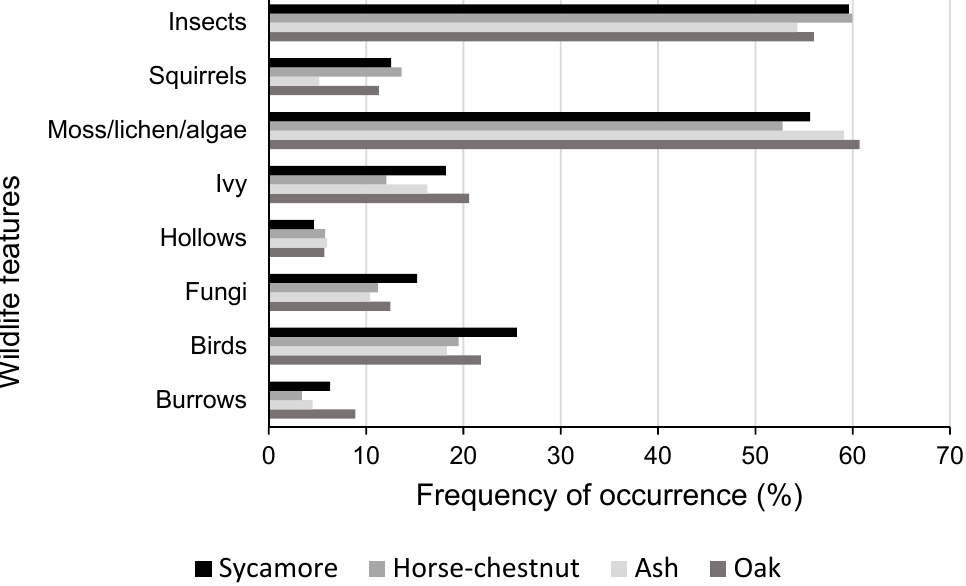
Figure 5. Frequency of occurrence of wildlife features recorded in the UK OPAL tree health survey.